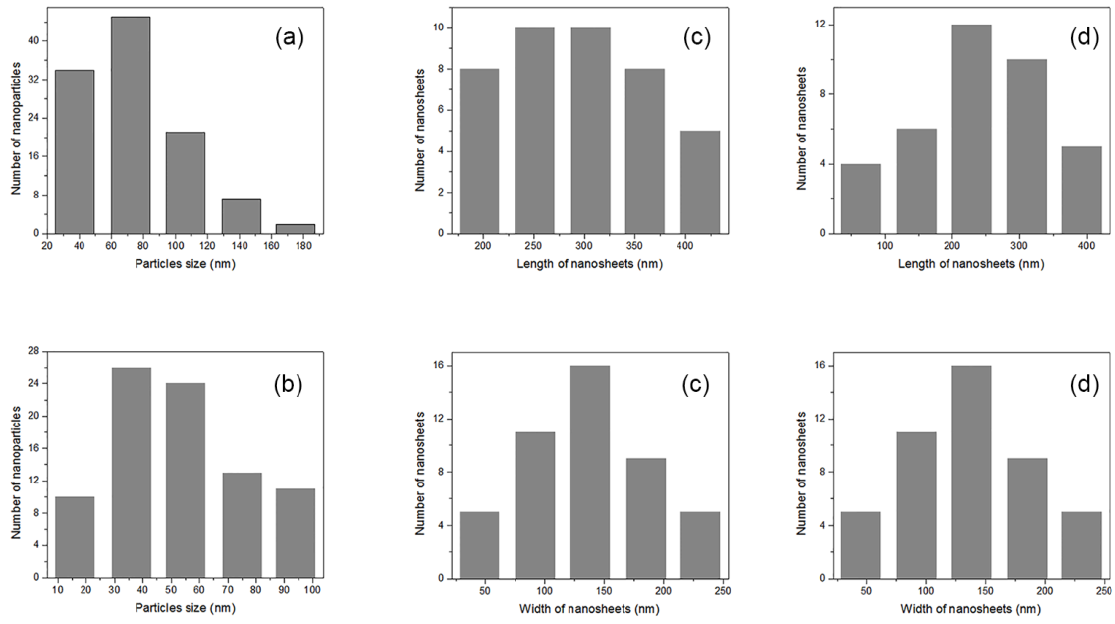
Figure 4. The size distribution of: ( a ) nanoparticles on CCP-CHT1-Cu10-AA; ( b ) nanoparticles on CCP-CHT2-Cu10-AA; ( c ) length and width of nanosheets on CCP-CHT1-Cu10-AA; and ( d ) length and width of nanosheets on CCP-CHT1-Cu10-AA.